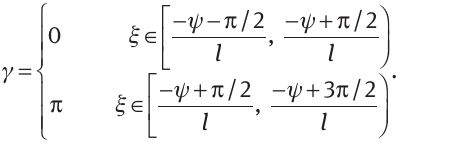
even HE expressed in CV mode bases. (B) | E | = (0, 1, 0, 0), α = (0, 0, 0, 0 ) or + 1, l m , I and δ along with polarized angle ψ . The patterns at the polarized angle 0 ° , 45 ° , 90 ° and 135 ° when D A